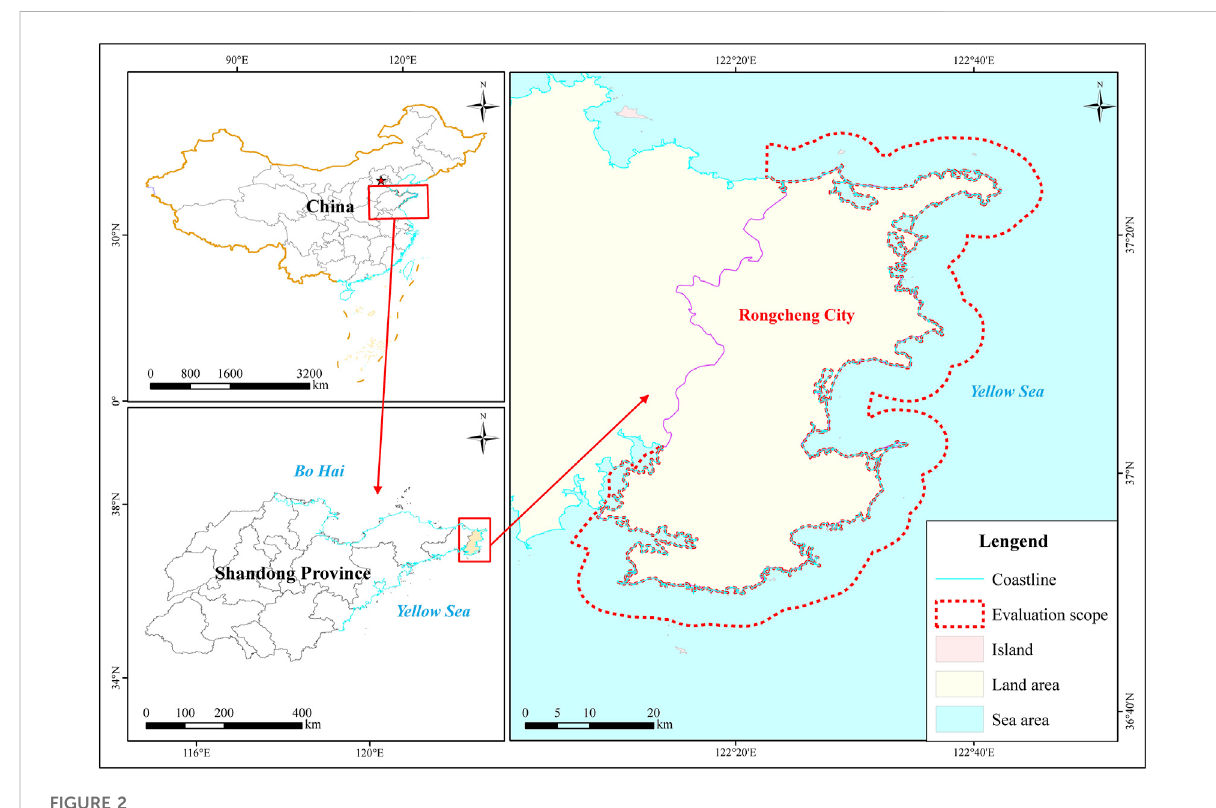
FIGURE 2 Study area and evaluation